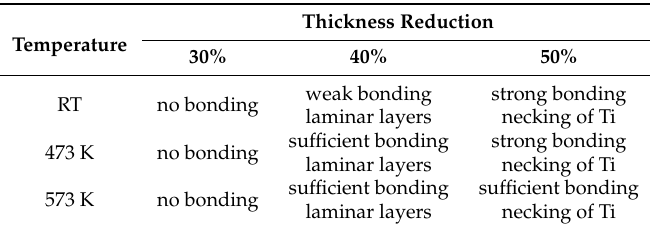
Table 1. Overview of elevated temperature